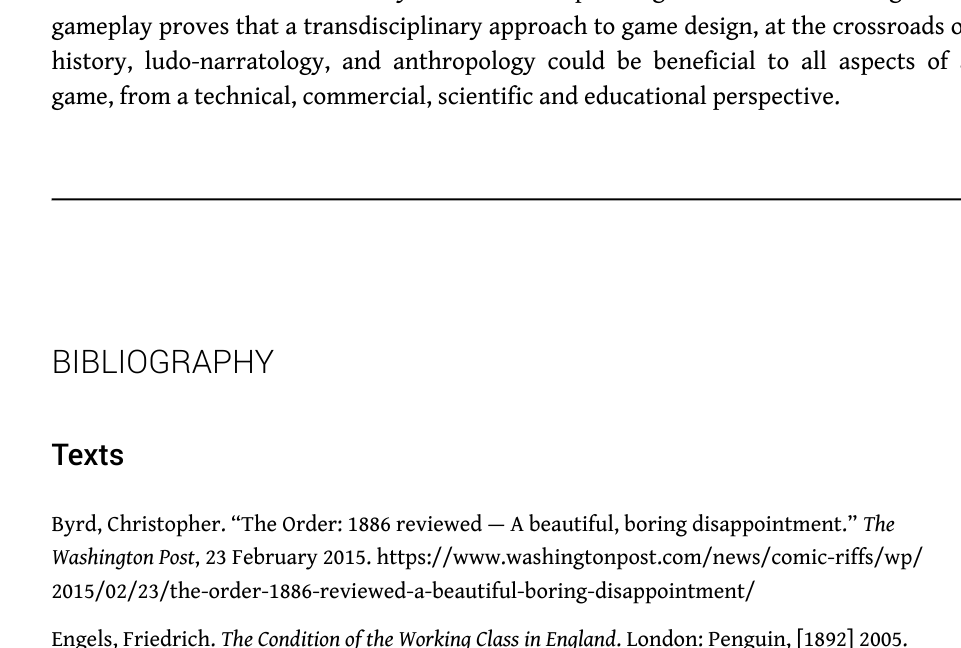
Credits: https://assassinscreed.fandom.com/wiki/London